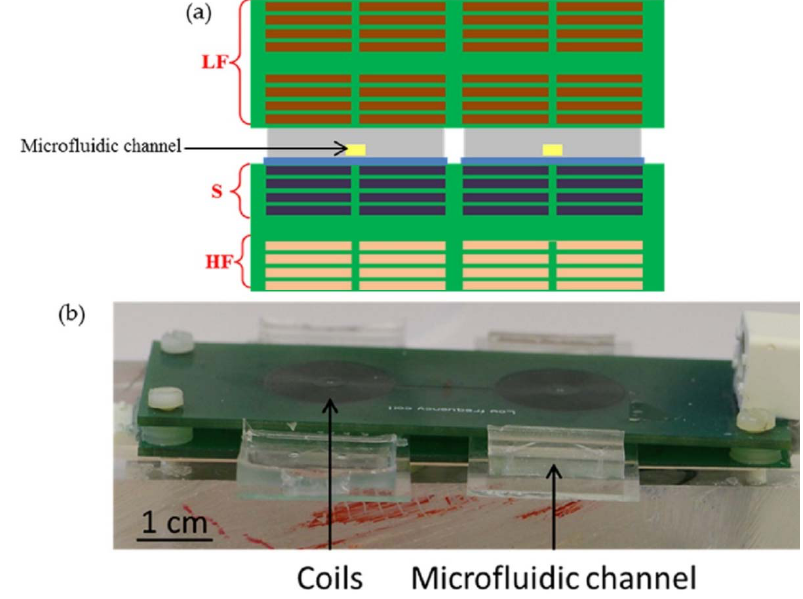
Figure 3. ( a ) Schematic description of the layers (front view): the two green blocks represent the two Printed Circuit Boards (PCBs) containing the coils (LF: Low Frequency, S: Sensor, and HF: High Frequency), the grey part represents the PDMS layers that contain the microfluidic channel (the yellow part), which are bonded to a glass slide (in blue); ( b ) Picture of the PCB/ microfluidic prototype detection structure.